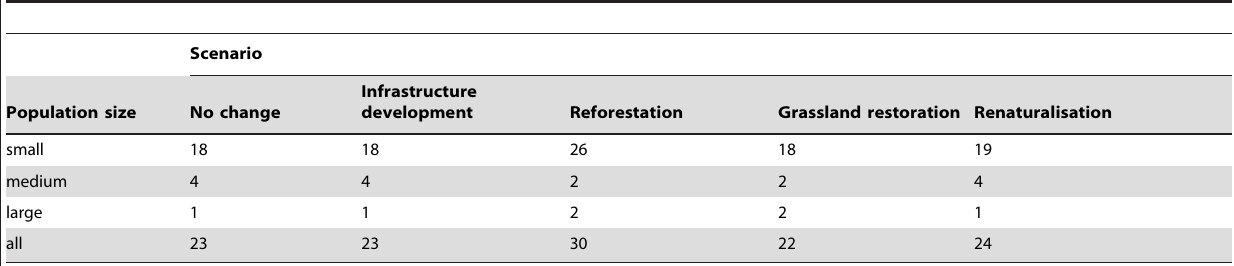
Table 2. Number of small ( , 125), medium ( $ 125 and , 375), and large ( $ 375 individuals) patches in each scenario.